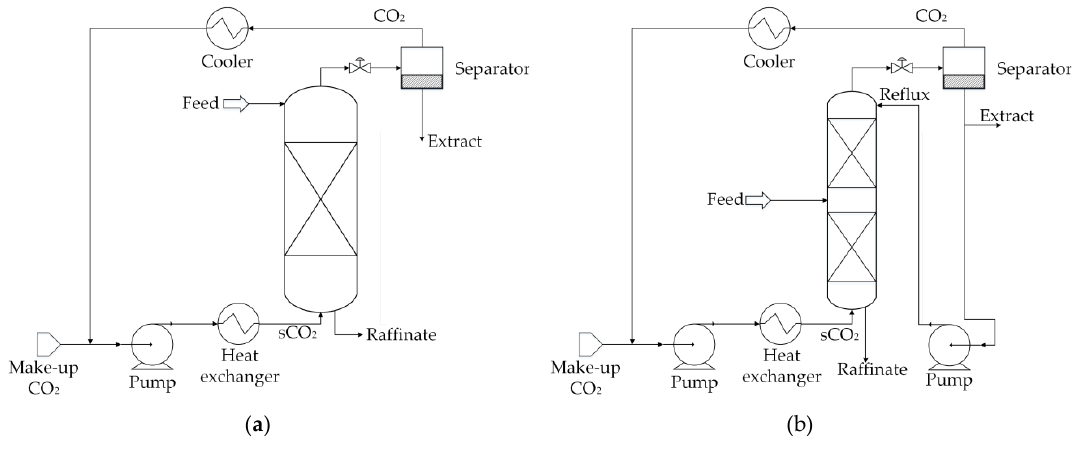
Figure 4. Flow diagram of continuous countercurrent extraction process. ( a ) Without reflux; ( b ) with reflux.